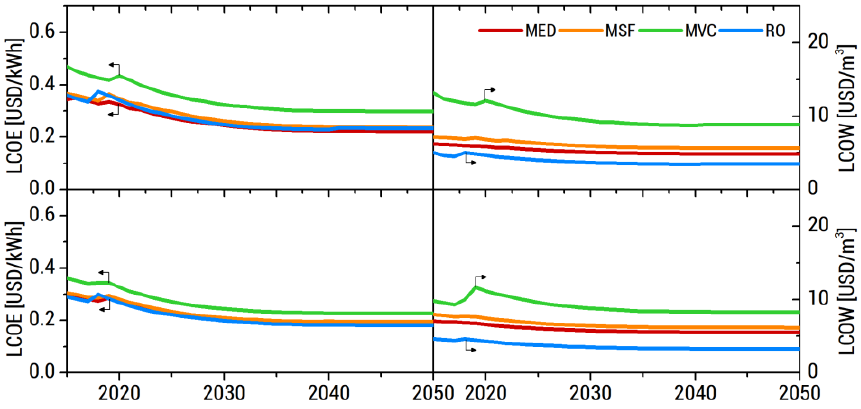
Figure 13. Monthly average PV power and water level on Camasusu Island ( top ) and Lubang Island ( bottom ). Note that stability of the system is ensured due to an imposed minimum water level of 20%.